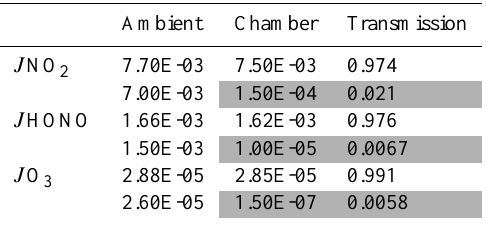
Table 1. Measurement of photolysis frequencies, J (s − 1 ), in the ambient air and the MOPS chambers. The shaded areas indicate photolysis frequencies measured inside the reference chamber (Ul- tem coated). Clear areas in the second and third columns correspond to measurements inside the sample chamber (clear). The last col- umn shows the transmission of chamber measurements with respect to the ambient.